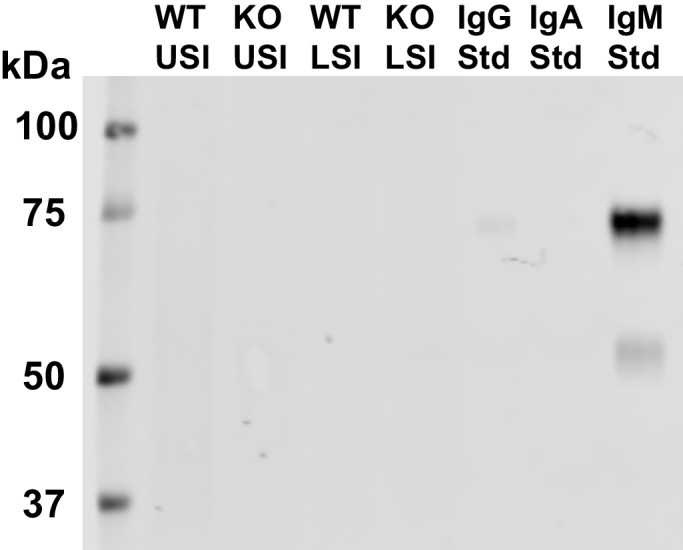
Western blots of 30 µm-filtered samples from the small intestine (SI) of wild-type (WT) and Rag1 knockout (Rag1KO) mice.WT USI = WT upper SI; KO USI = KO lower SI; WT LSI = WT lower SI; KO USI = KO upper SI. For detection of IgM, 1:10,000 dilution of Li-Cor IRDye 800CW Goat Anti-Mouse IgM was used. We do not detect IgM in any of the SI samples.